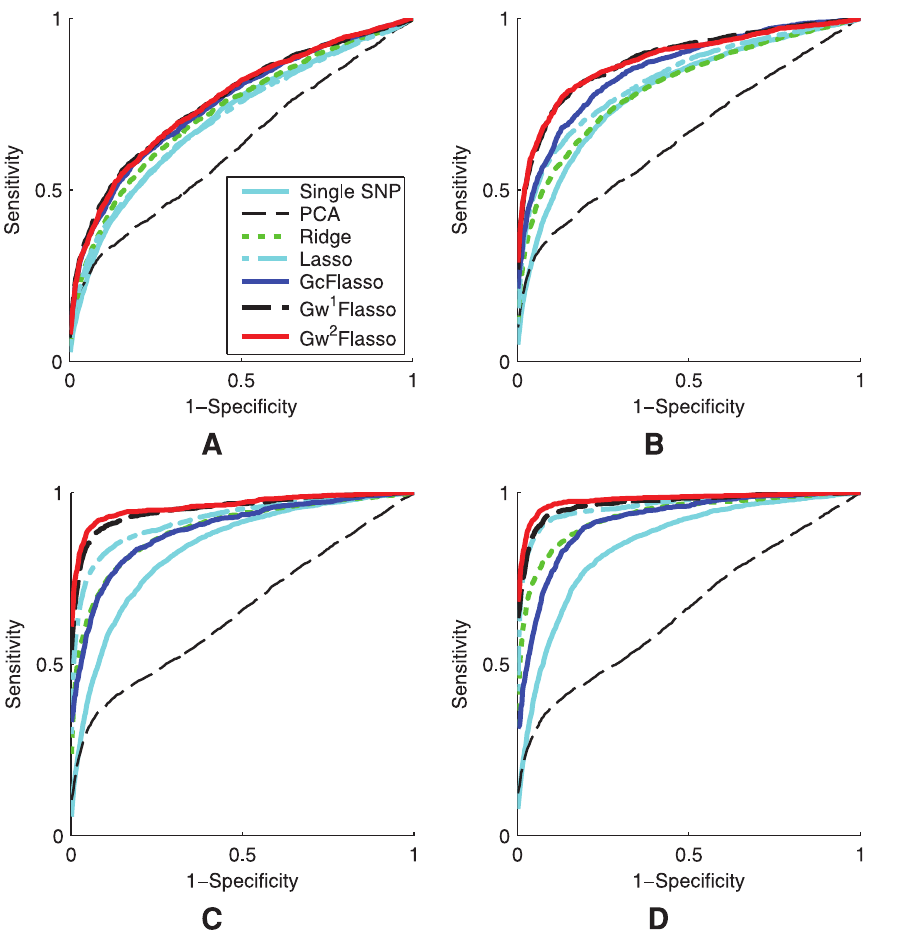
Figure 6. ROC curves comparing the performance of association analysis methods when the association strength varies. Panels show results for association strength (A) 0.3, (B) 0.5, (C) 0.8, and (D) 1.0. The sample size was 100, and the threshold r for producing the QTN was set to 0.1. The results were averaged over 50 simulated datasets. In Panel (A), the ROC curves for G c Flasso , G 1 Panel (B), the ROC curves for G 1 Flasso and G 2 Flasso almost entirely overlap. w w